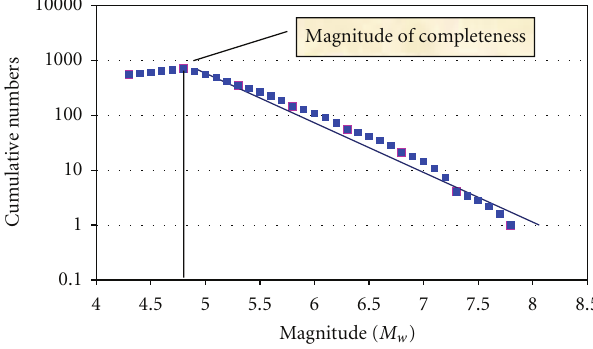
Figure 4: Frequency-magnitude distribution for Yemen and sur- rounding seismic